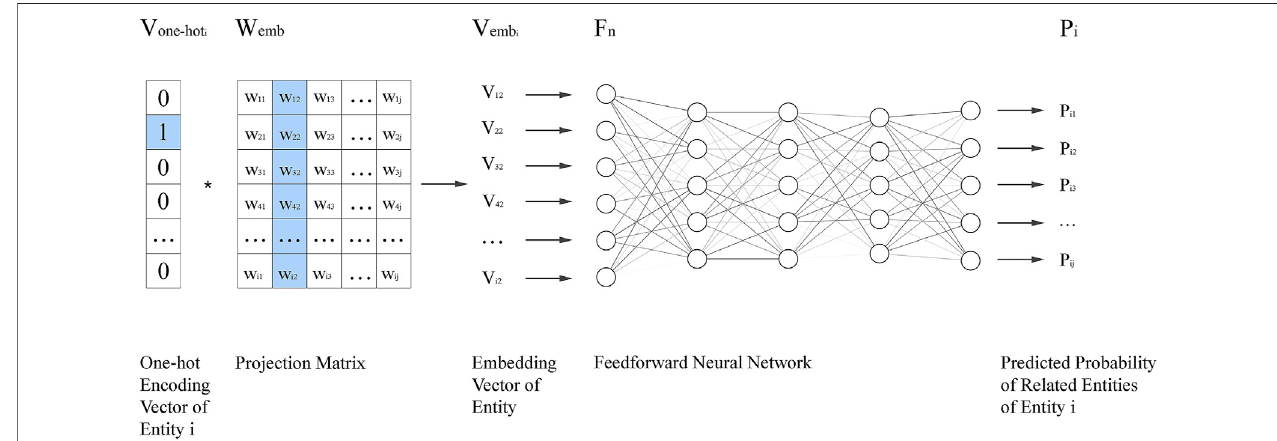
is the one-hot encoding vector of the entity A(i), W emb is the projection matrix, F n is a i